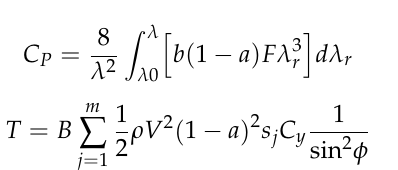
l theoretical C p C p calculated by test Figure 4. C p calculated by test versus theoretical value.